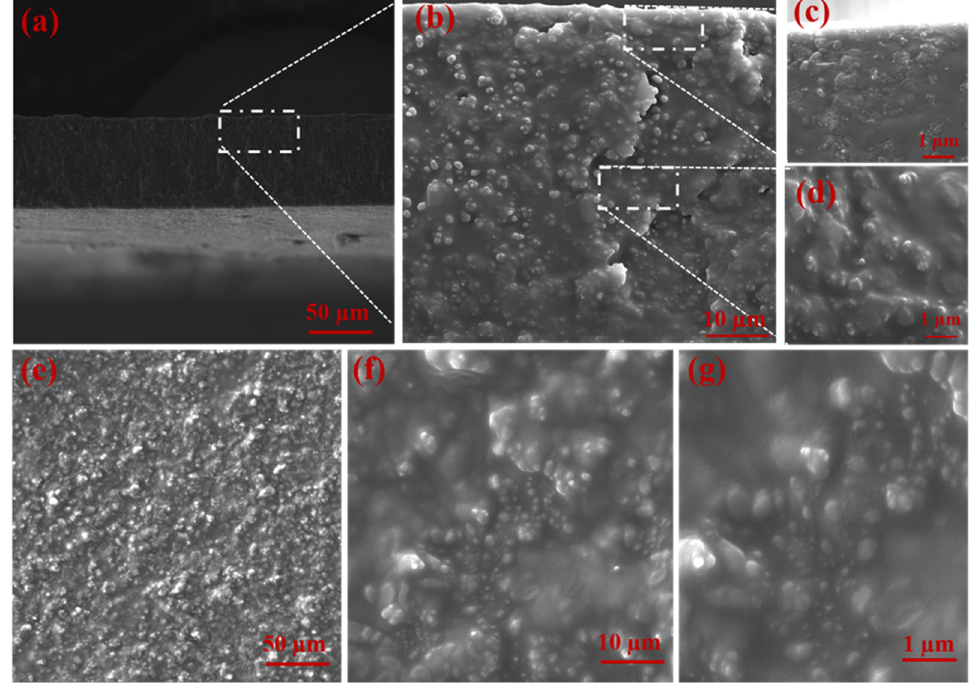
Figure 3. SEM images of cross-sectional view PVAm-PVA-UiO-66-NH 2 ( a – d ) and the surface mor- phology PVAm-PVA-UiO-66-NH 2 ( e – g ).